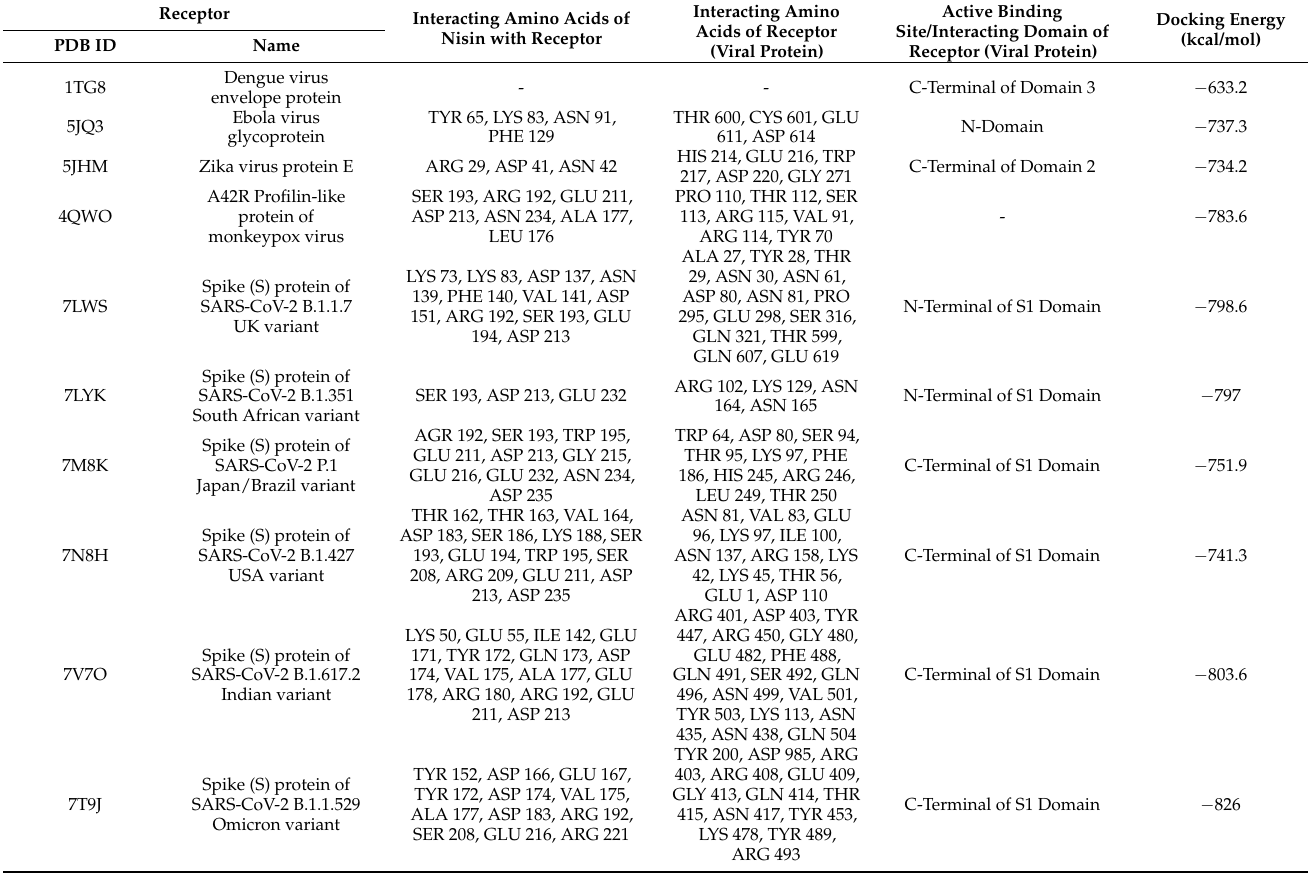
Table 5. Molecular docking analysis of nisin (PDB ID: 5XHB) derived from L. lactis .